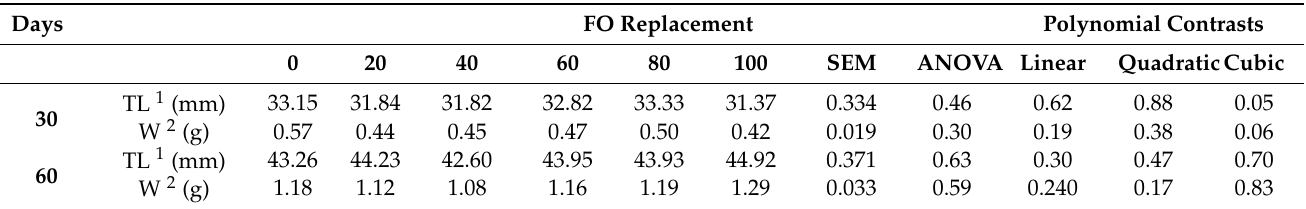
Table 4. Growth performance of juvenile tench fed experimental diets with different levels of cod liver oil replacement by a blend of vegetable oils over 30 and 60 days.